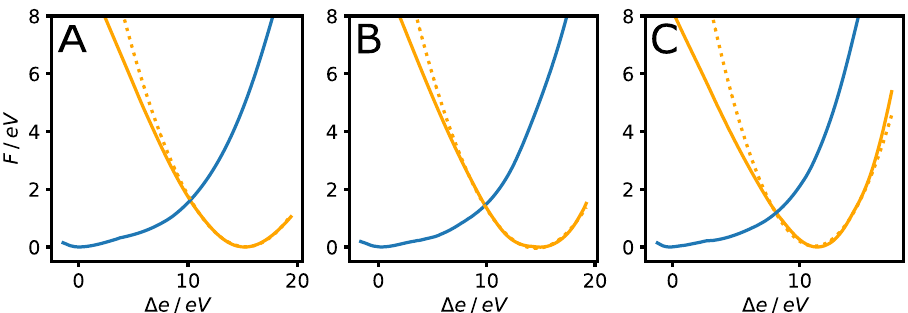
cell electrostatic potential is set to V (cid:2) V pzc =0V, i.e., the PZC for both electrodes. The orange and blue curves correspond to the oxidized and reduced states, respectively. Parabolas fi tted near the proton minimum are shown asdashedlines.